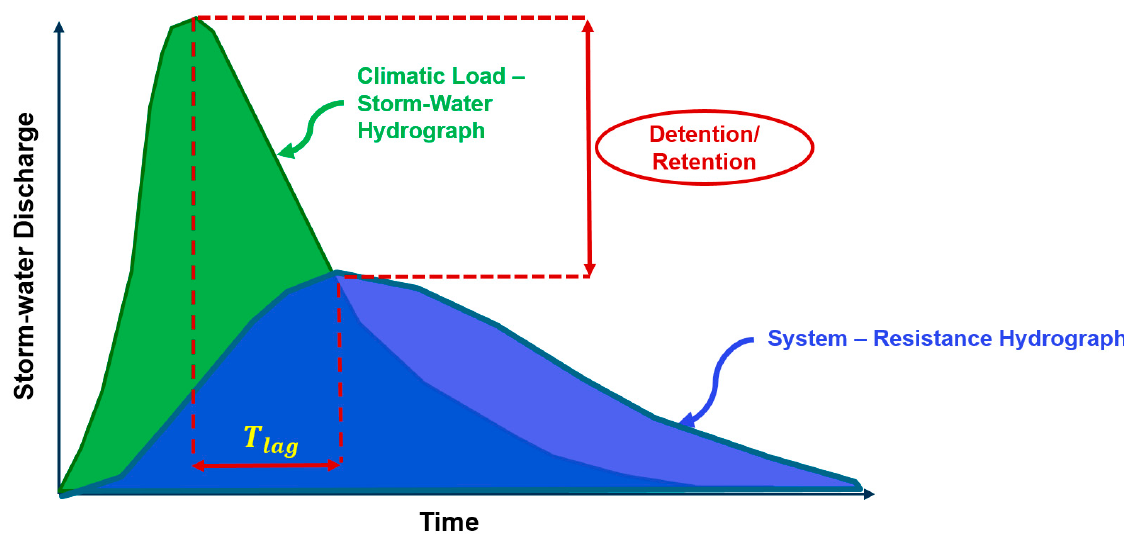
Figure 4. Hydrographs for a storm ‐ water detention assessment.